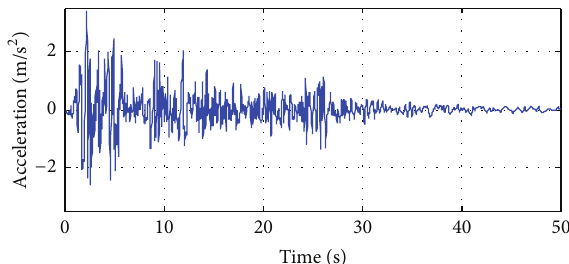
Figure 4: Maximum absolute control efforts corresponding to the controlled building with the ideal state-feedback energy-to-peak ̃𝐺 controller defined by the gain matrix 𝑠 . The full scale North-South El Centro 1940 seismic record has been used as ground acceleration